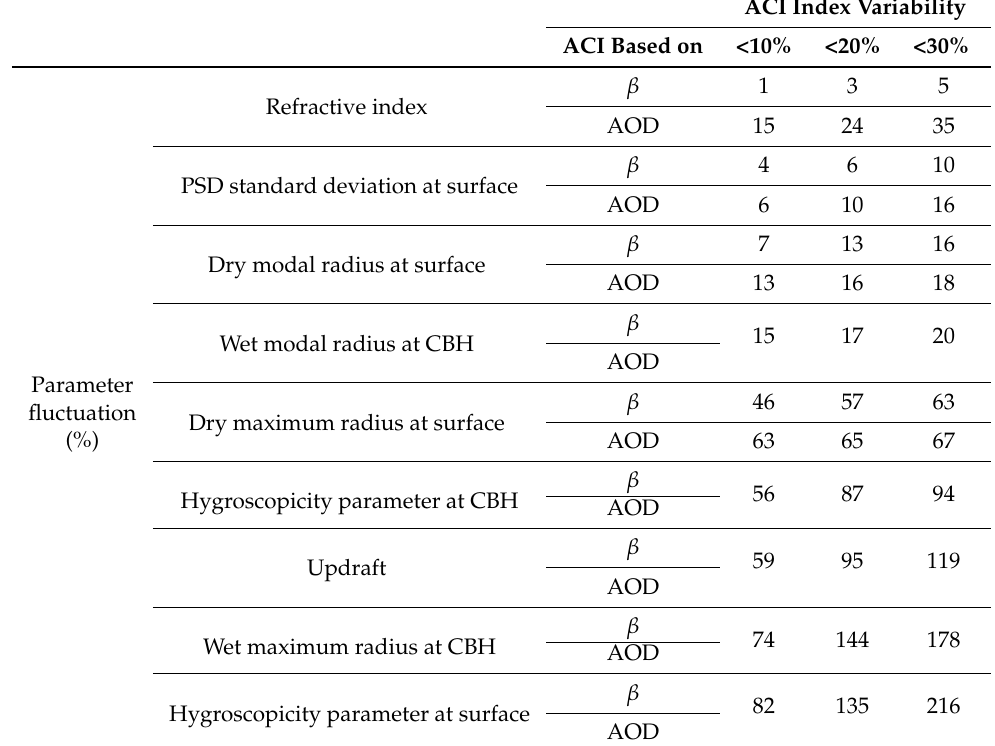
Table 7. Fluctuation range of each parameter to retrieve the ACI index based in the backscatter coefficient ( β ) or the aerosol optical depth ( AOD ) with a variability lower than 10%,20% and 30%. Parameters are sorted according to their influence on ACI ref f uncertainty (Up, higher influence). R 2 remains above 0.6 for all parameters, except for hygroscopicity parameter at CBH ( R 2 = 0.31) and the updraft velocity ( R 2 =